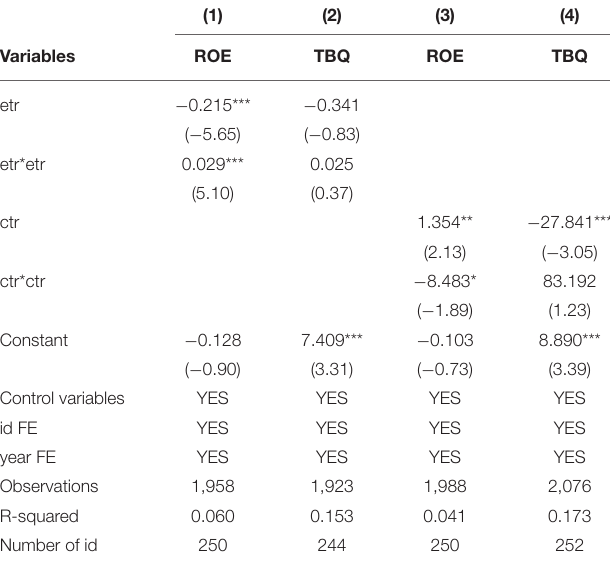
TABLE 8 | Regression results of adding quadratic